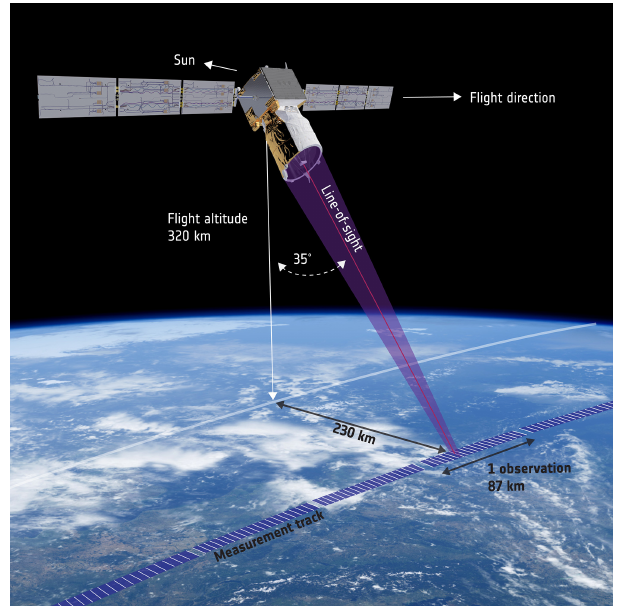
Figure 1. Sounding geometry of Aeolus (© ESA).